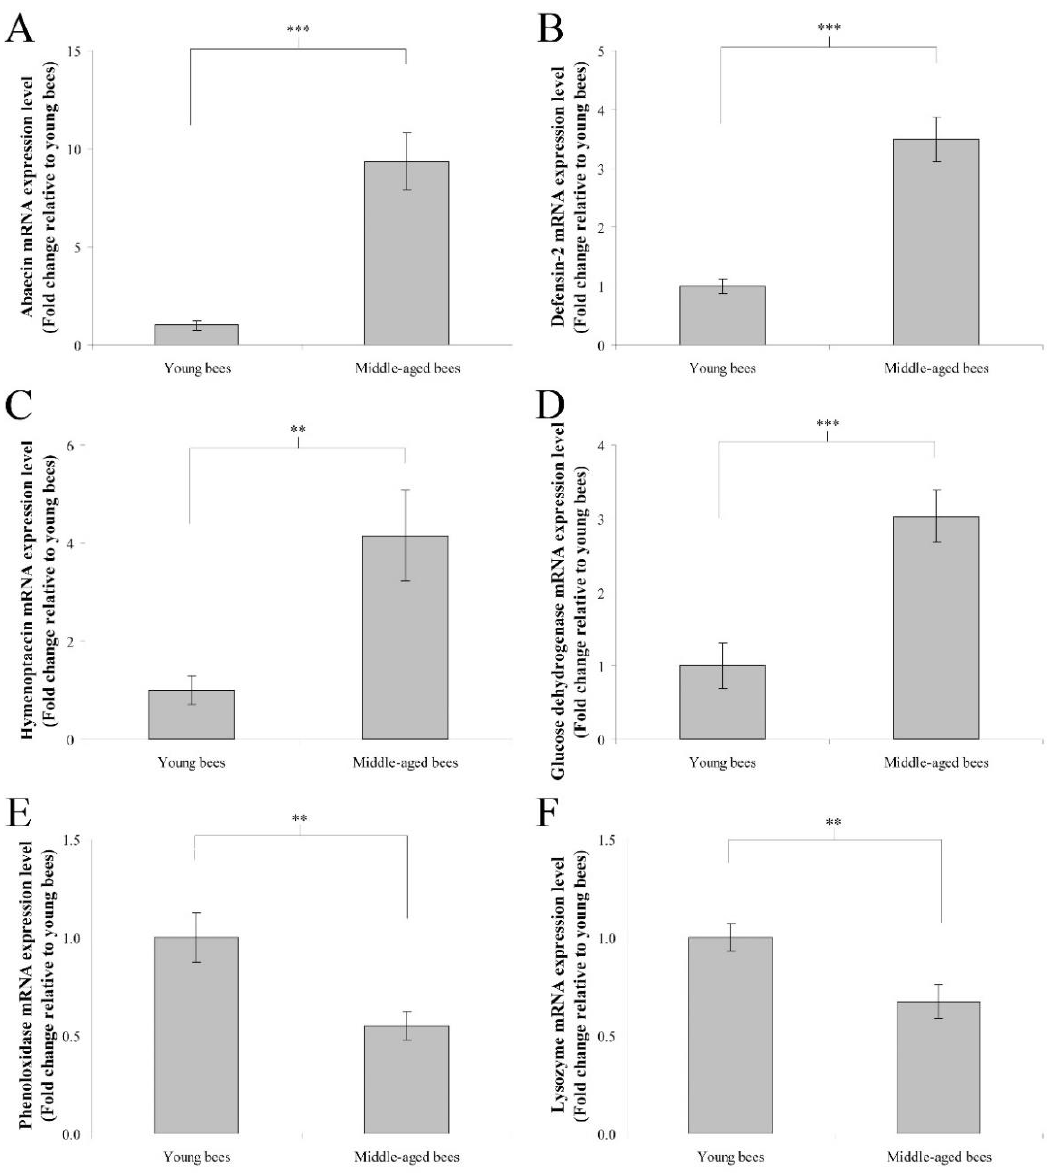
Figure 1. The genes expression of abaecin, defensin-2, hymenoptaecin, glucose dehydrogenase, phenoloxidase, and lysozyme from the whole body of young and middle-aged worker bees reared in field hives. The mRNA expression levels of abaecin ( A ), defensin-2 ( B ), hymenoptaecin ( C ), glucose dehydrogenase ( D ), phenoloxidase ( E ), and lysozyme ( F ) genes were normalized to young worker bees and shown as fold changes, representing the mean ± standard error of the means (SEMs) ( n = 10). The asterisks indicate significant differences (** p < 0.01, *** p < 0.001; two-sample t